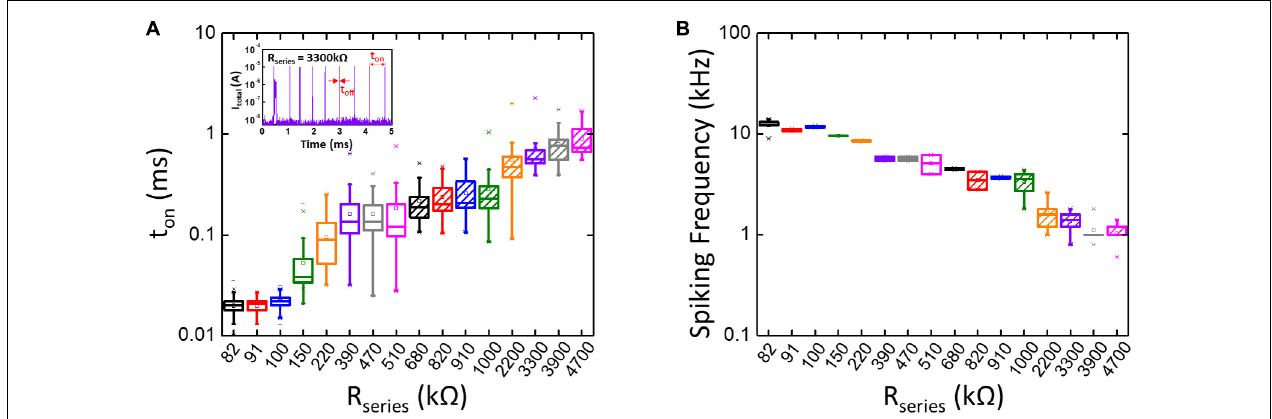
FIGURE 3 | (A) The measured t on increases with increasing R series while the calculated spike frequency shown in panel (B) decreases with increasing R series in the neuron circuit. The inset in panel (A) shows an example of the experimentally obtained spike current ( I total ) when R series is 3,300 k (cid:127) . The spike frequency is defined by the number of spikes per second (Hz). The spike frequency is approximately equal to the inverse of t on when R series is greater than 100 k (cid:127) and t on is much larger than t off .